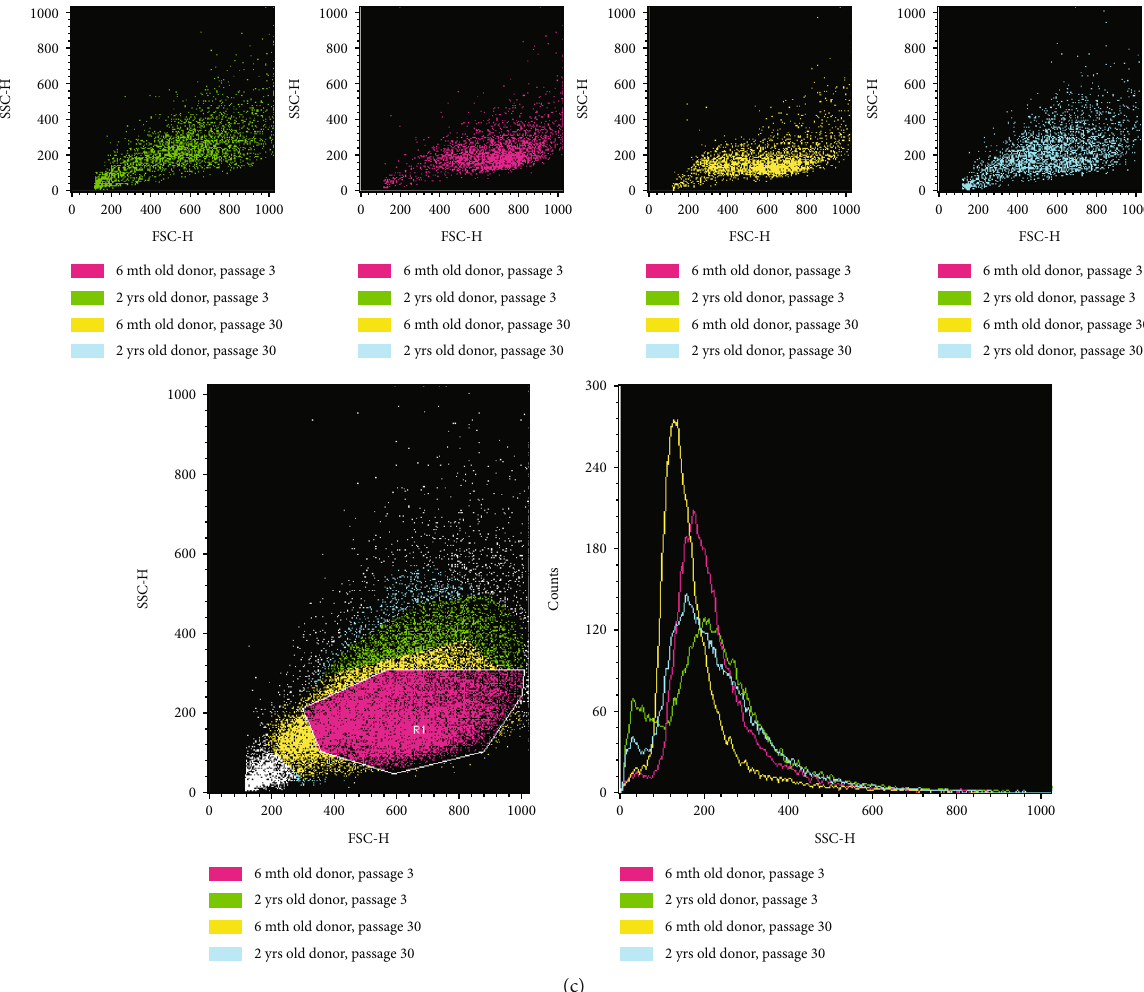
Figure 1: (a) Comparison of the cell surface expression CD29 and CD90 from short-term (passage 3) and long-term (passage 30) in vitro cultures of rats 6mth old and 2yrs. old; (b) morphology of ASCs from short term (3 passage) of 6mth old donors and 2yrs. old donors and of ASCs from long- term (30 passage) culture of 6mth old donors and 2yrs. old donors; (c) fl ow cytometry analysis (FSC/SSC) of the granulation of ASCs from 2yrs. donors, 3 p. (passage) and 30 p. and 6mth donors, 3 p. and 30 p. Comparison of the extent of granules is shown below. Table 1: Comparison of the growth rate and doubling time of ASCs from passage 3 (p. 3) and passage 30 (p. 30) from 6 mth and 2 yrs. donor rats (Doubling Time Online Calculator). ASC donor (rat) age and passage (p.)